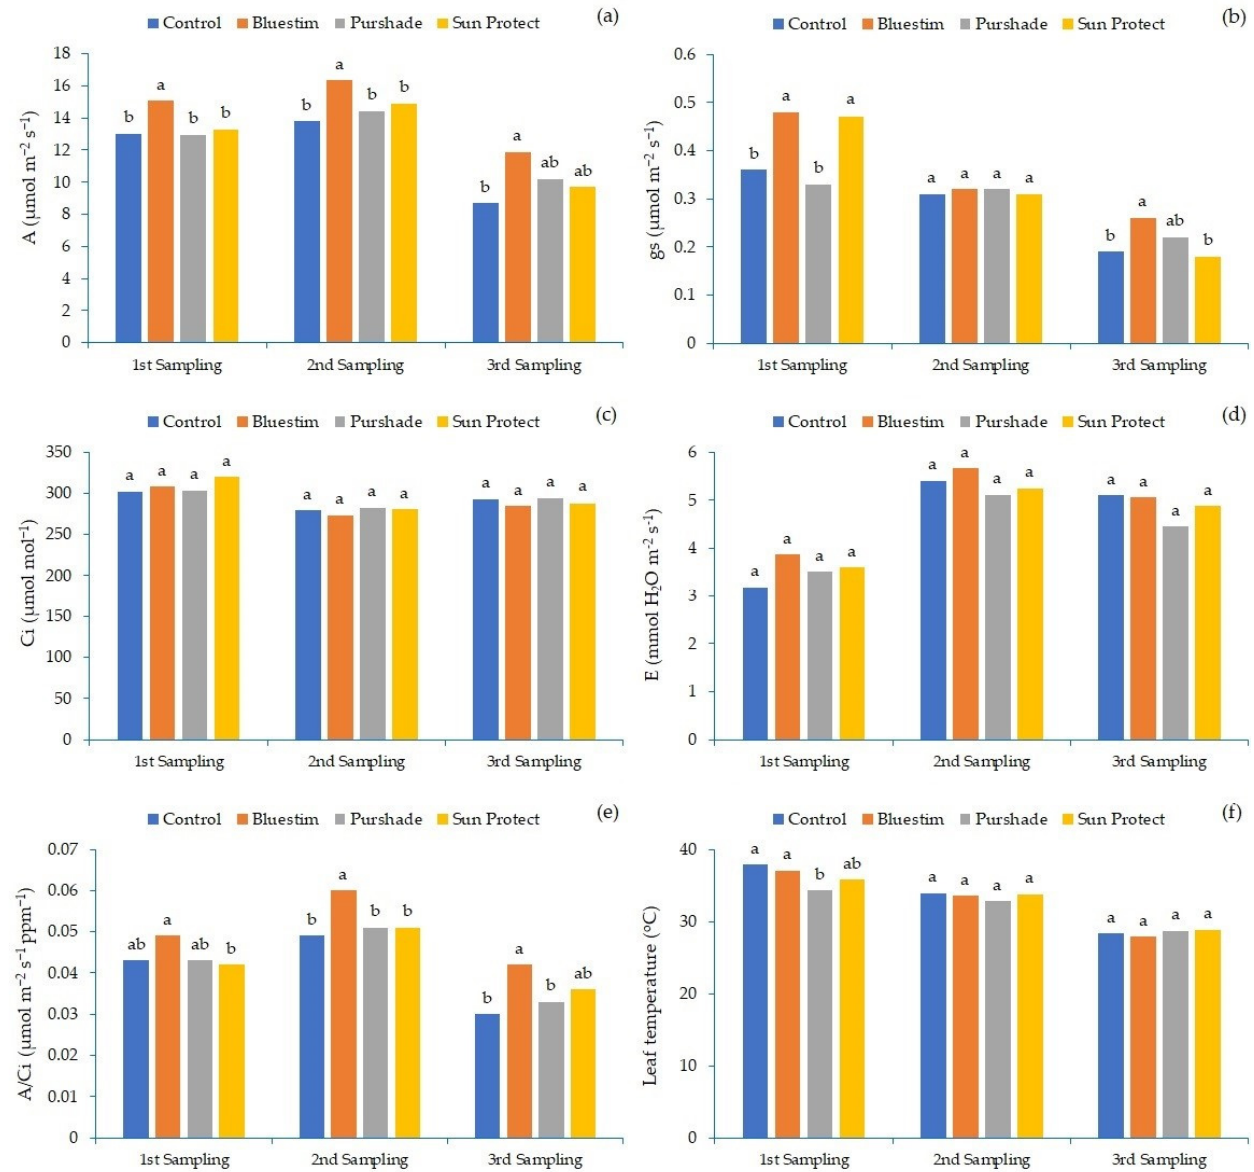
Figure 1. Effect of alleviating products on the photosynthetic parameters ( a ) A, photosynthesis ( µ moL m − 2 s − 1 ), ( b ) gs, stomatal conductance (moL m − 2 s − 1 ), ( c ) Ci, intercellular CO 2 ( µ moL moL − 1 ) ( d )